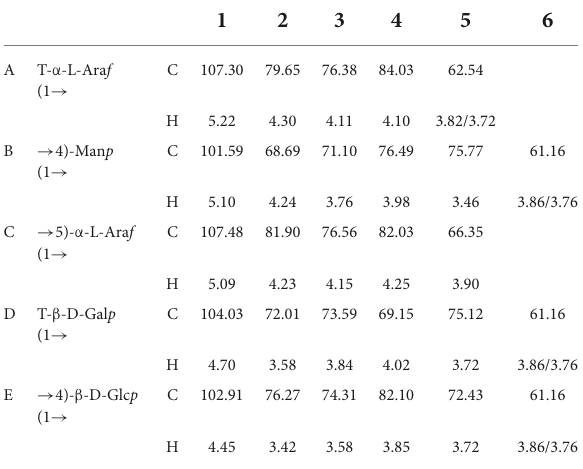
TABLE 4 Assignments of 1 H and 13 C NMR spectra for EFP-2.